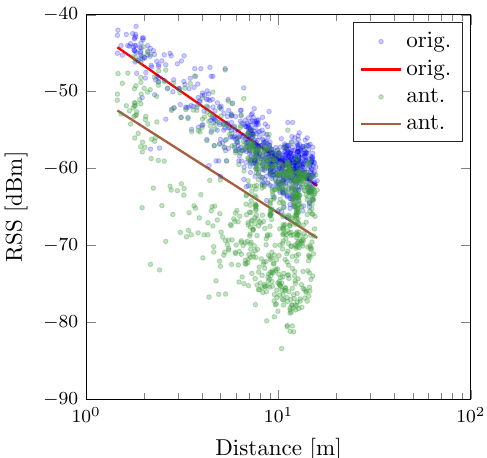
( a ) Comparison of RSS-distance scatter plots for a node in the basketball court without and with a directional antenna ( κ = 0.1).